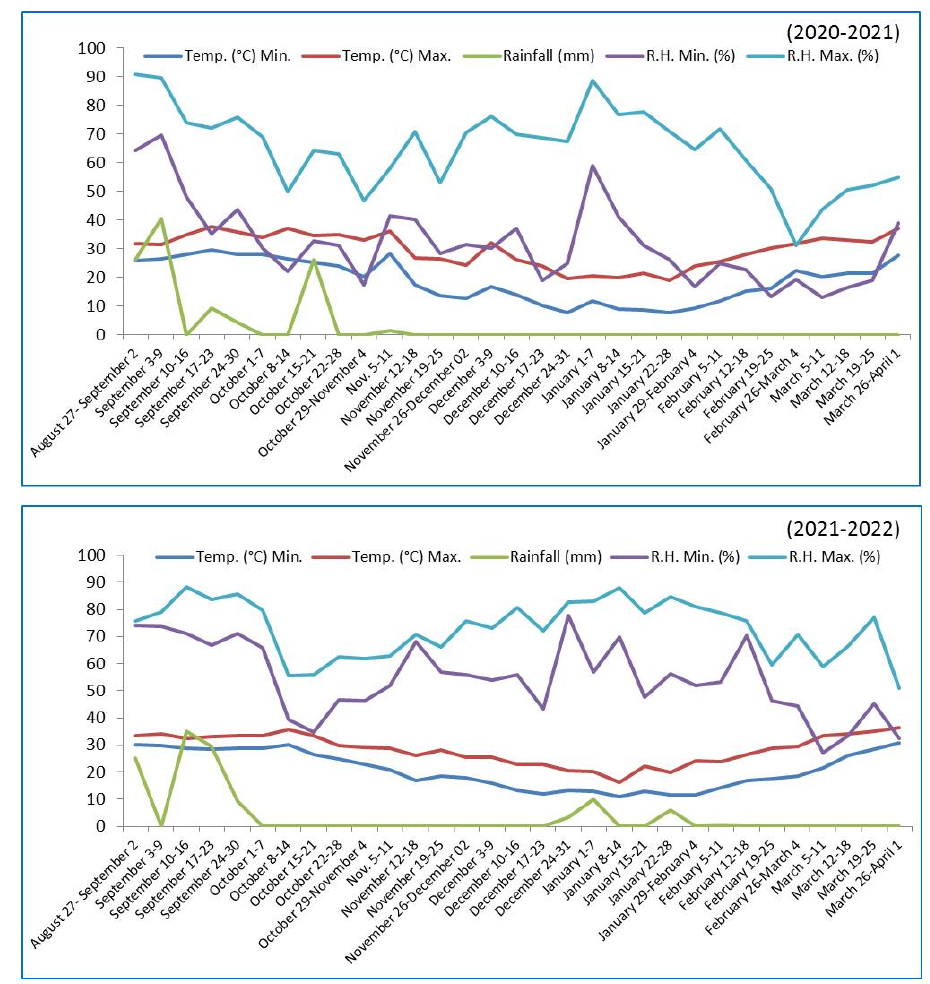
Figure 2. Weekly meteorological parameters during the Rabi seasons of 2020–2021 and 2021–2022.